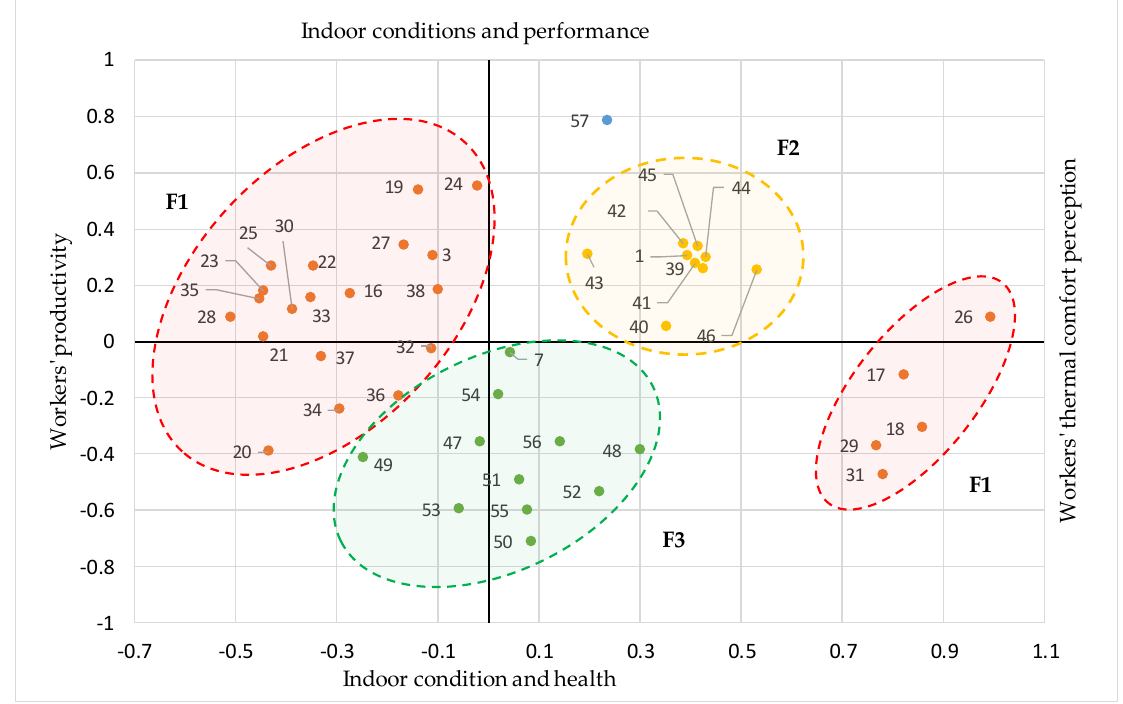
Figure 2. Multidimensional Scaling Map. Circles on the map are drawn according to the main three clusters of Table 2.